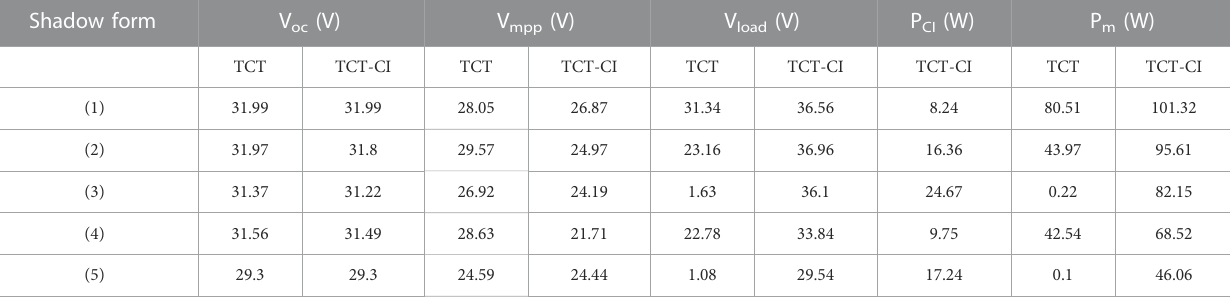
TABLE 7 Comparison of experimental